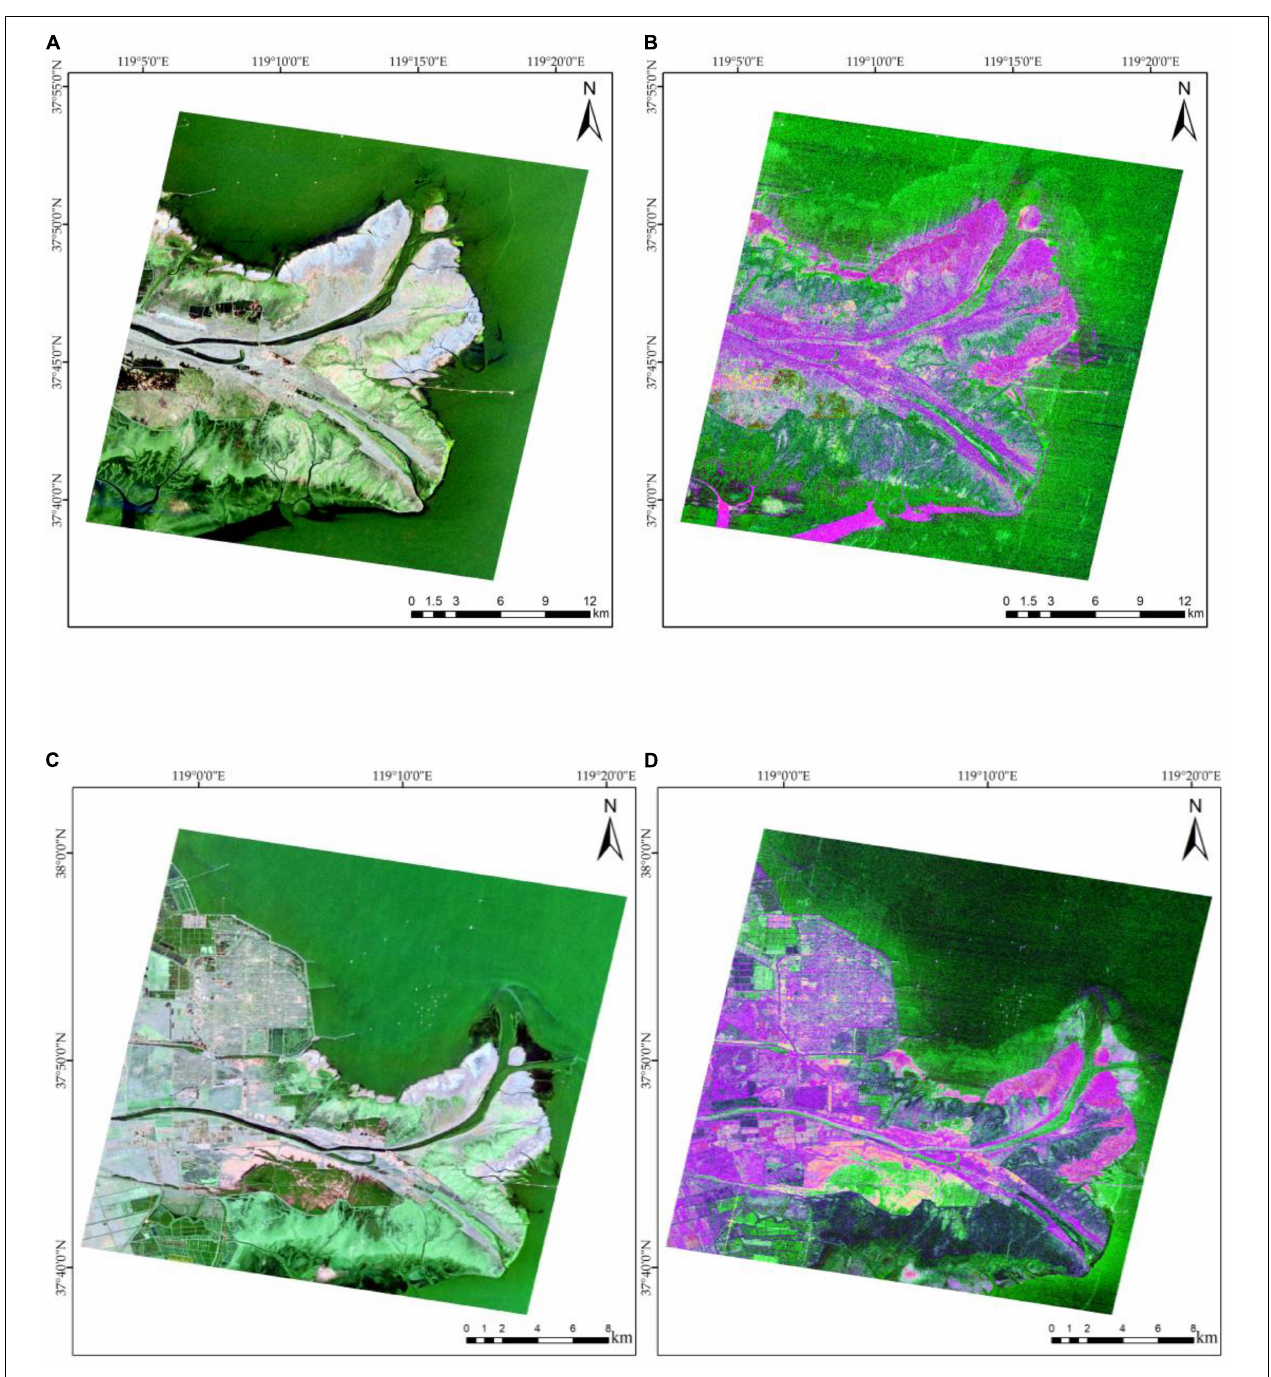
FIGURE 5 | Results of polarization decomposition. (A,C) Are the Pauli decomposition figures for October 2017 and November 2018, respectively. (B,D) Are the H/ α /A decomposition figures for October 2017 and November 2018, respectively.